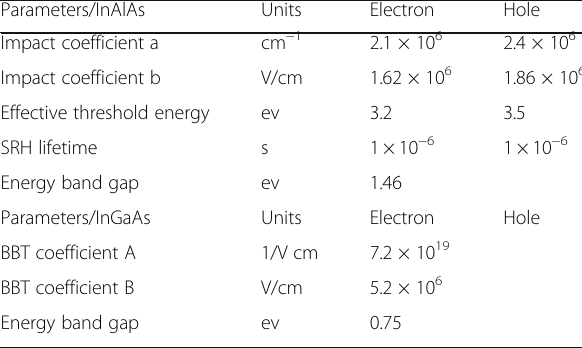
Table 1 Material parameters used for InGaAs/InAlAs APD simulation [18, 26]